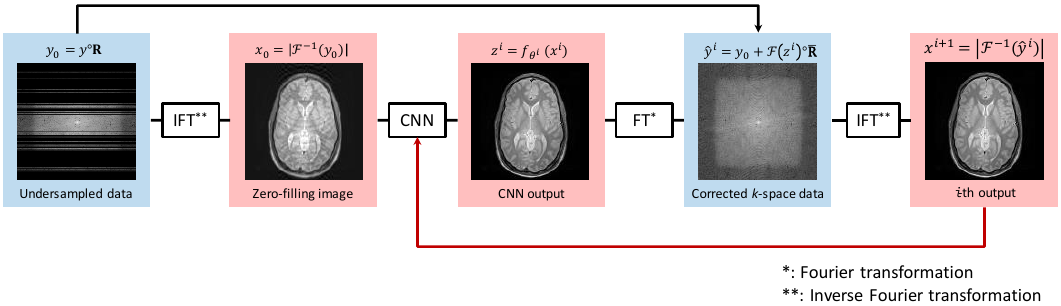
Figure 1. Sequential schematic of the proposed iterative method with the blue and red regions representing the k-space and image space, respectively.